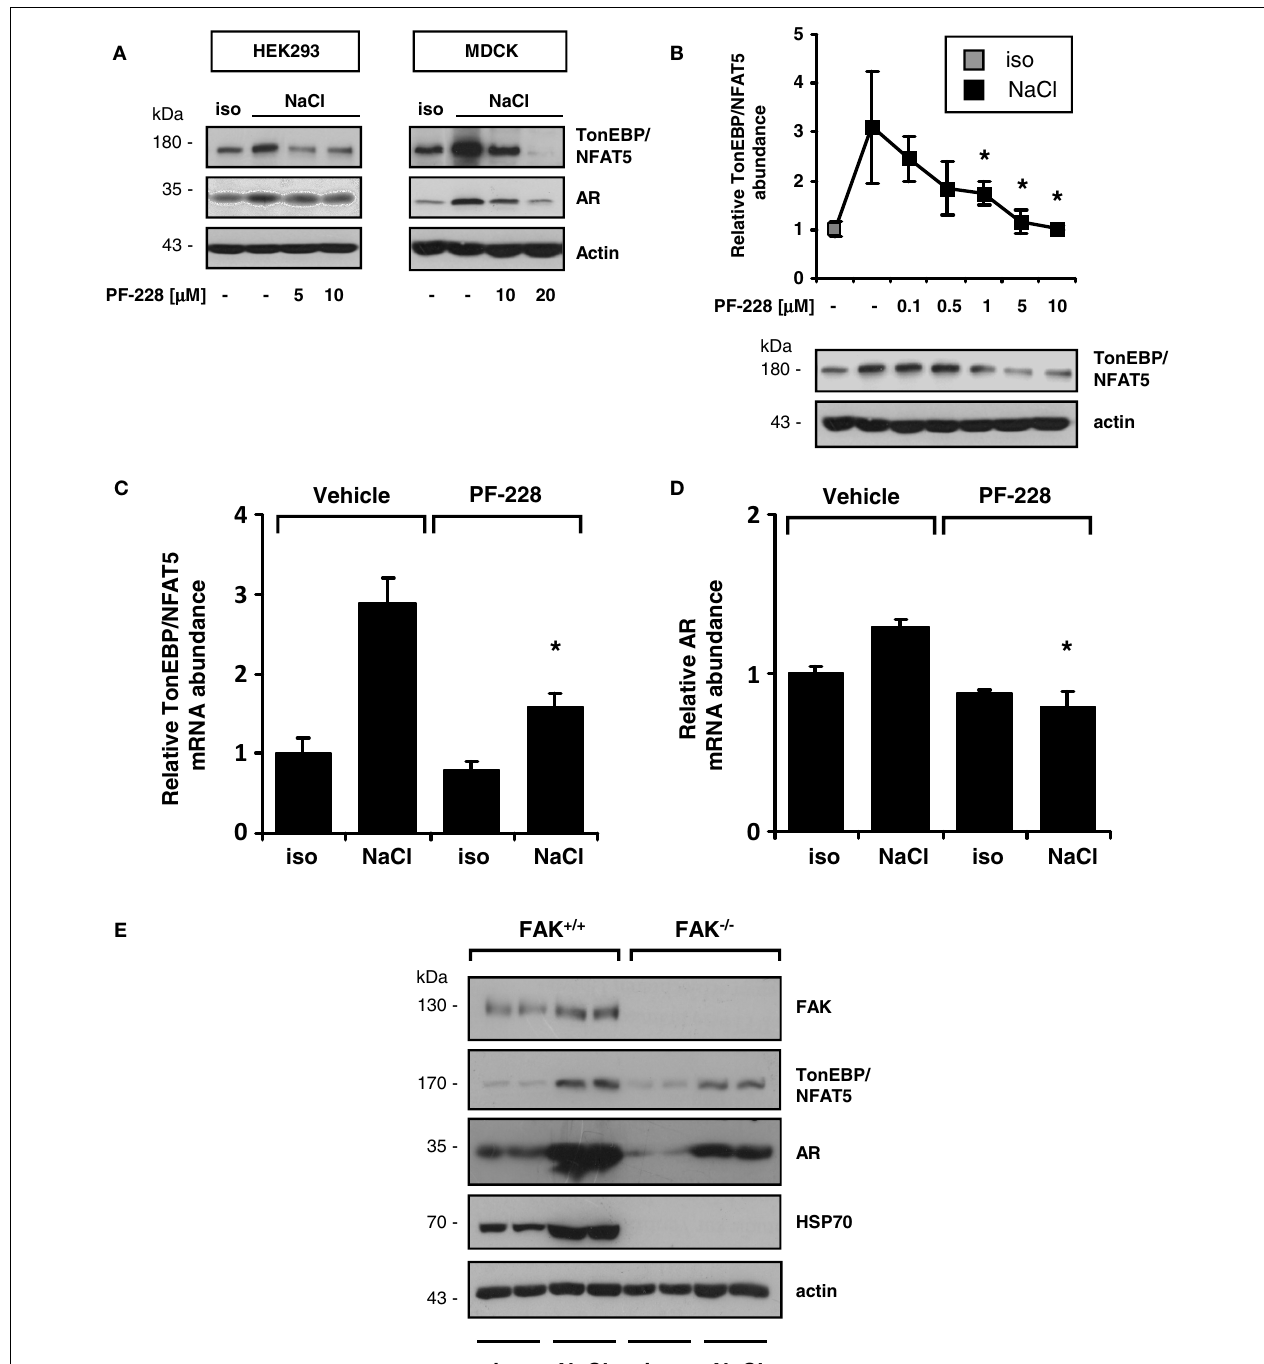
∗ p < 0 . 05 vs. NaCl + vehicle. (C,D) Expression of TonEBP/NFAT5 and AR mRNA in HEK293 cells under the indicated conditions. The data were normalized to actin mRNA abundance. The data are means ± s.e.m. for n = 3. ∗ p < 0 . 05 vs. NaCl + vehicle. (E) FAK + / + and FAK − / − MEF were incubated in isotonicmediumorexposedtohypertonicmedium(450mosm/kgH 2 ObyNaCl addition) for 24h. Subsequently, the expression of FAK, TonEBP/NFAT5, AR, and HSP70 was determined by Western blot analysis. Representative blots of three independent experiments are